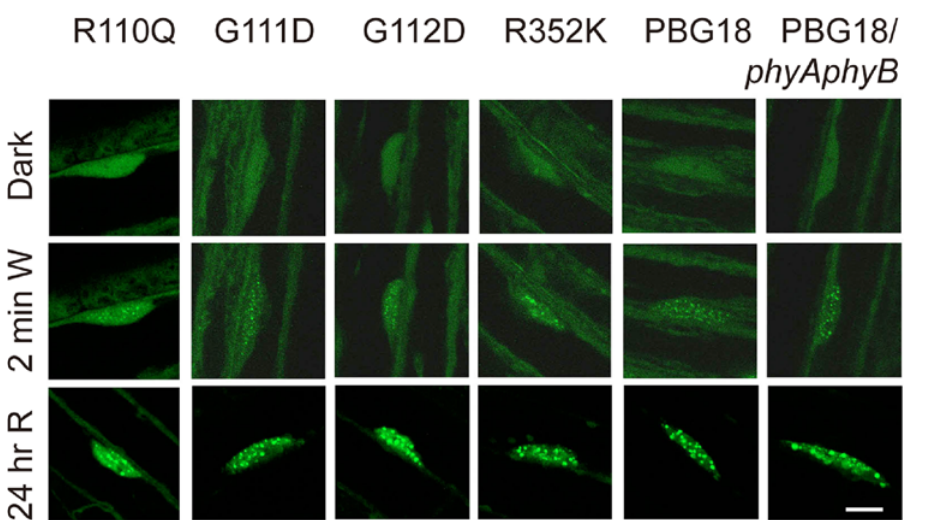
Figure 7. Subcellular Localization of Mutant Forms of PBG. Confocal microscopic observation of GFP fluorescence in transgenic Arabidopsis seedlings. Hypocotyl epidermal cells of 3-day-old seedlings were observed. Dark-grown seedlings (upper), those treated with cW for 2 min (middle) and those treated with cR for 24 hr (lower) are shown. The bar indicates 10 m m.